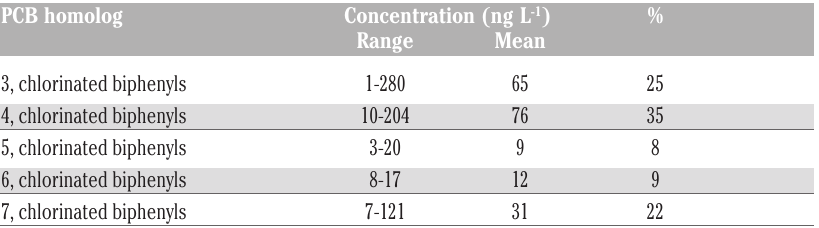
Table 2. Concentration of polychlorinated biphenyl homolog and their percentage in Yamuna River water. PCB homolog Concentration (ng L -1 ) %